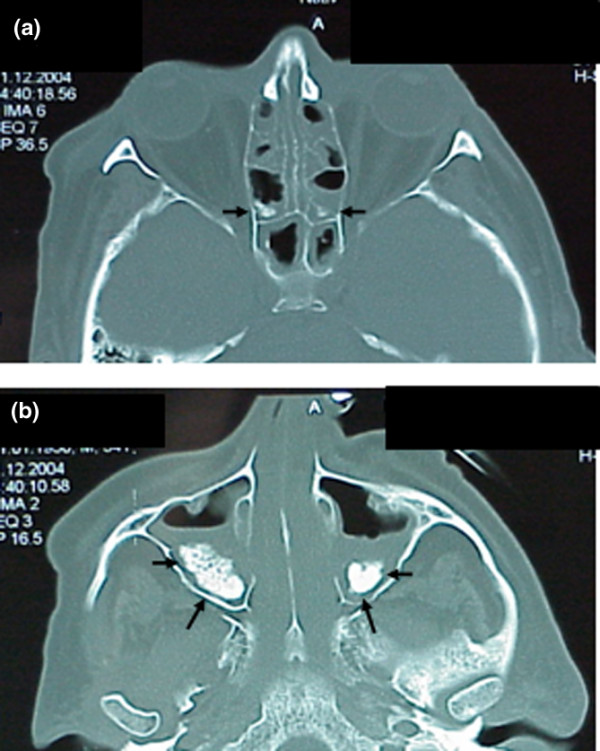
Computed cranial tomography (CCT): Arrows indicate fluid and opaque material in the (a) ethmoid and (b) maxillary sinuses.